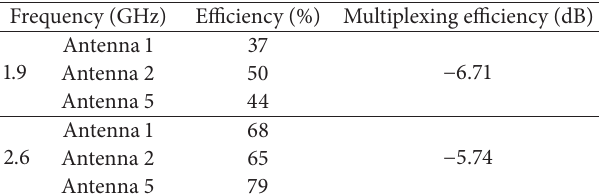
Table 4: Antenna